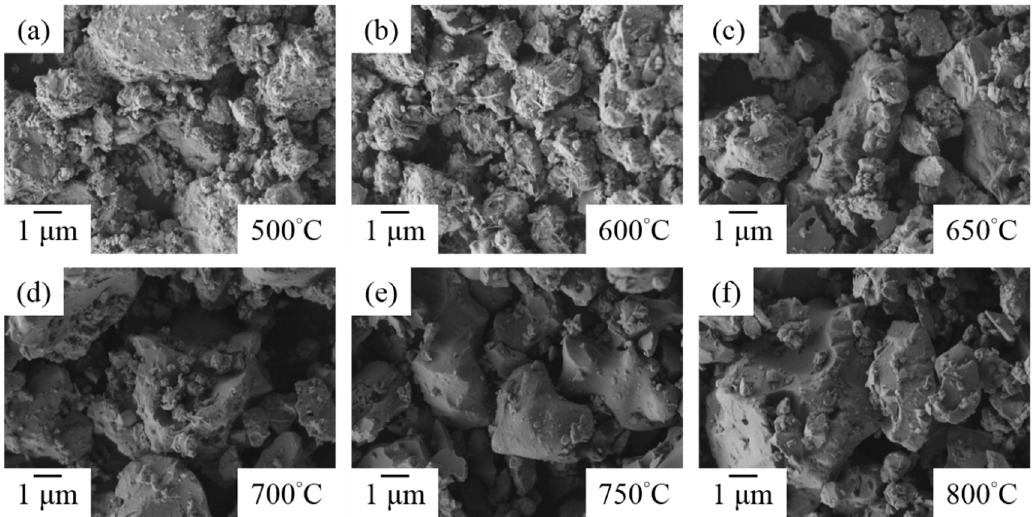
Figure 7. SEM images of Bi 1.8 Zr 0.2 O 3.1 powders after heat treatment at temperatures of: ( a ) 500 °C; ( b ) 600 °C; ( c ) 650 °C; ( d ) 700 °C; ( e ) 750 °C; and ( f ) 800 °C.